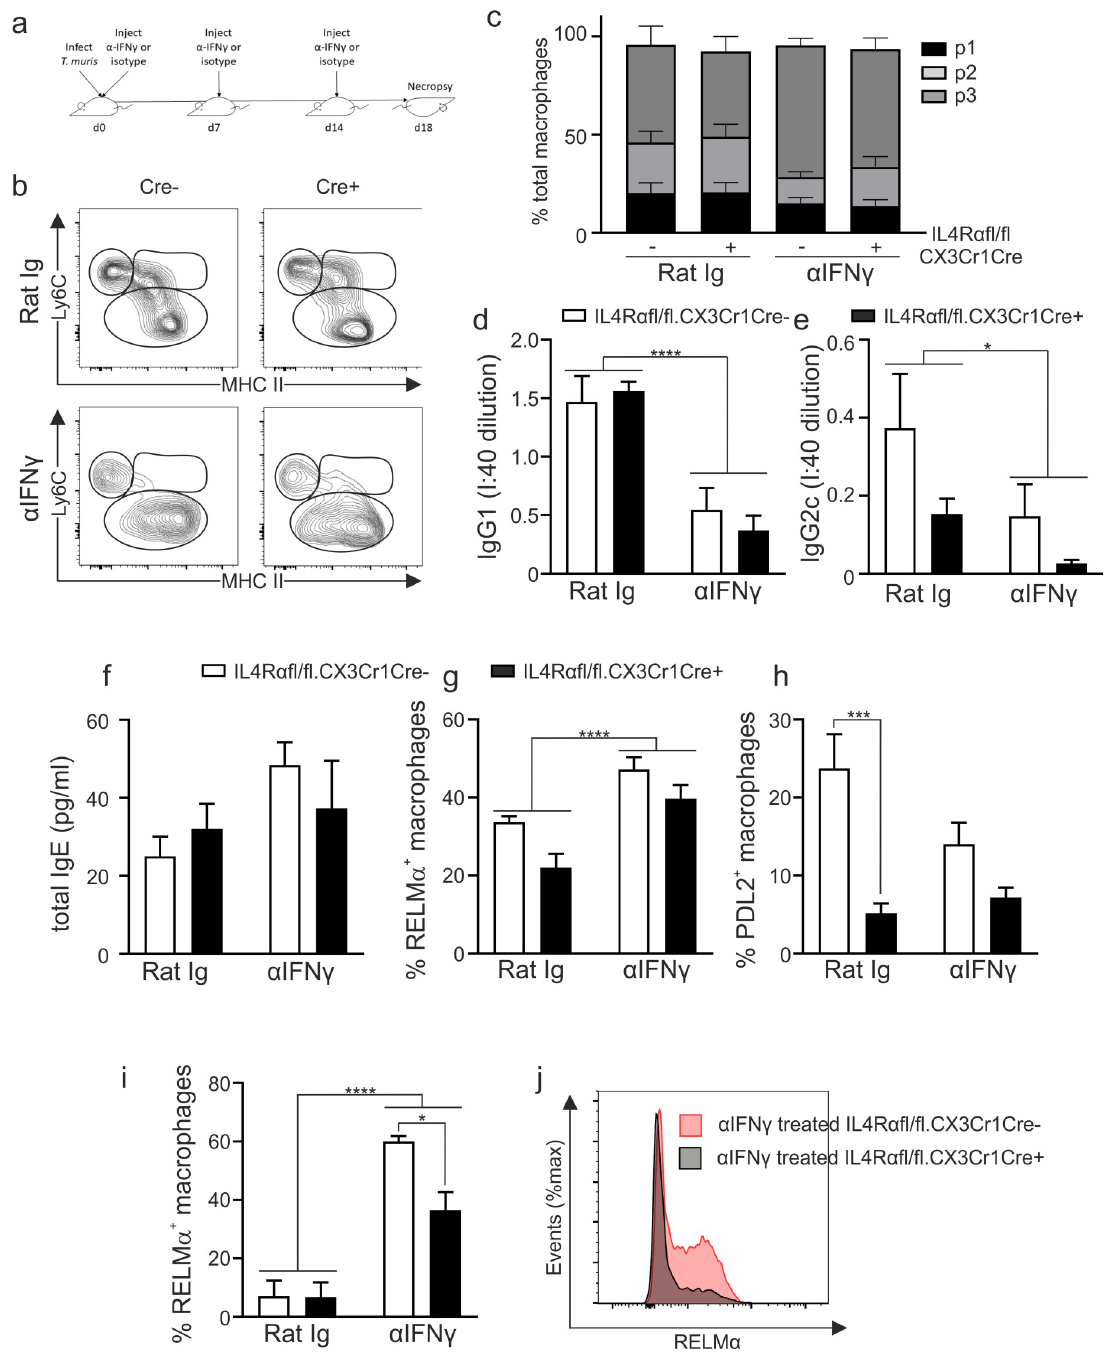
Fig 5. Intestinal RELM α + macrophages develop independently of IL4R α expression following α IFN γ treatment during T . muris infection. (a) IL4R α fl/fl.CX3CR1Cre+ or IL4R α fl/fl.CX3CR1Cre- mice were infected with 200 T . muris eggs and treated with α IFN γ or isotype mAb every 7 days during infection. Gut macrophages (gated as CD45 + CD11b + CD11c low/int SiglecF - Ly6G - ) were divided into P1 monocyte (CD64 - Ly6C hi MHCII - ), P2 transitioning monocyte (Ly6C + MHCII + ) and P3 macrophage (CD64 + Ly6C - MHCII + ) compartments in the colon and caecum. (b) Representative plots illustrating the P1-3 gates in IL4R α fl/fl.CX3CR1Cre- and IL4R α fl/fl. CX3CR1Cre+ mice following α IFN γ or isotype mAb at d18 post infection (c) Proportion of macrophages within the P1-P3 gates post infection with T . muris . Parasite-specific (d) IgG1 and (e) IgG2c production and (f) total IgE production at d18 post infection. Expression of the markers RELM α (g) and PD-L2 (h) within the total monocyte/macrophage (P1-3) population. (i) Expression of RELM α within F480 hi MHCII lo peritoneal macrophage population. (j) Representative plots illustrating the RELM α expression in the α IFN γ treated